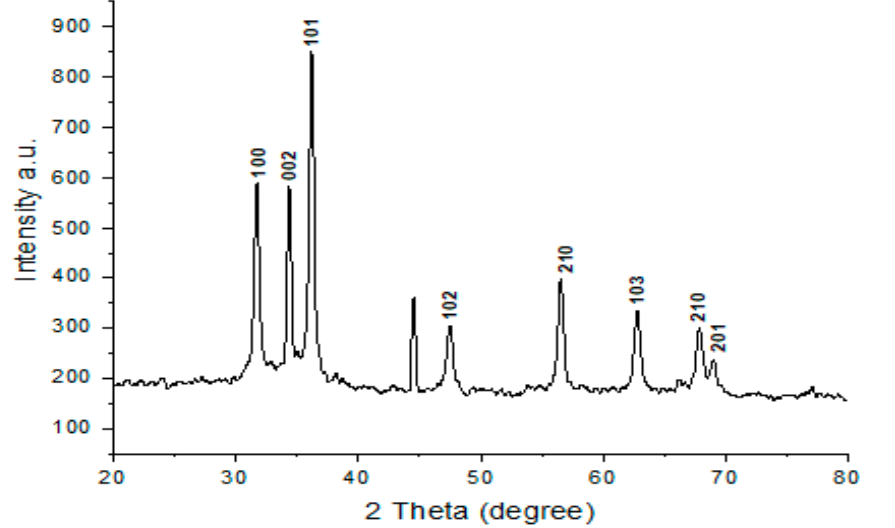
Figure 4. X-ray diffraction analysis (XRD) of the bio-synthesized ZnONPs using P. zonale leaves extract.